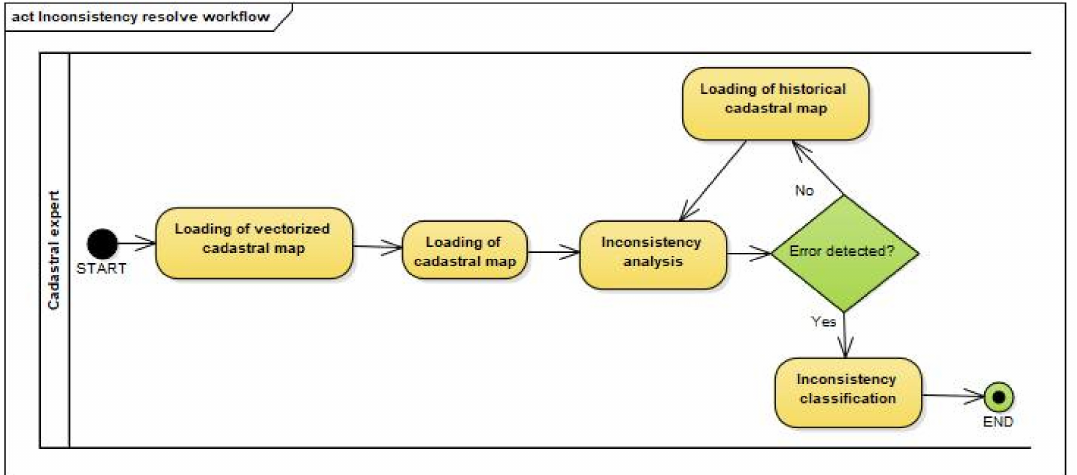
Figure 3. Resolving inconsistencies. Source: own